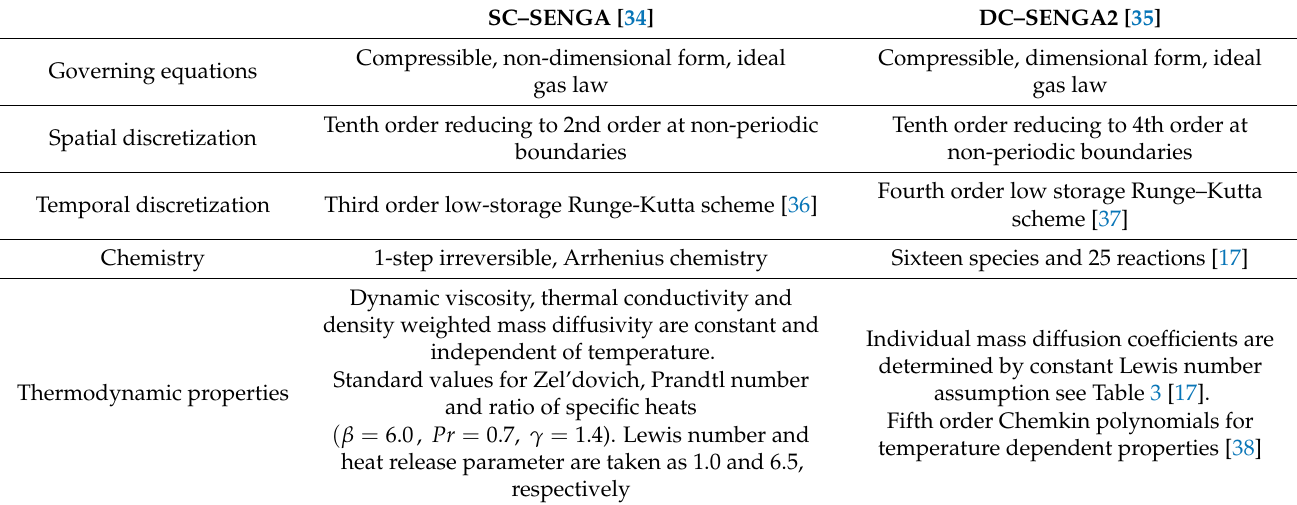
Table 1. Numerical methods and physical models used for the DC and SC simulations.